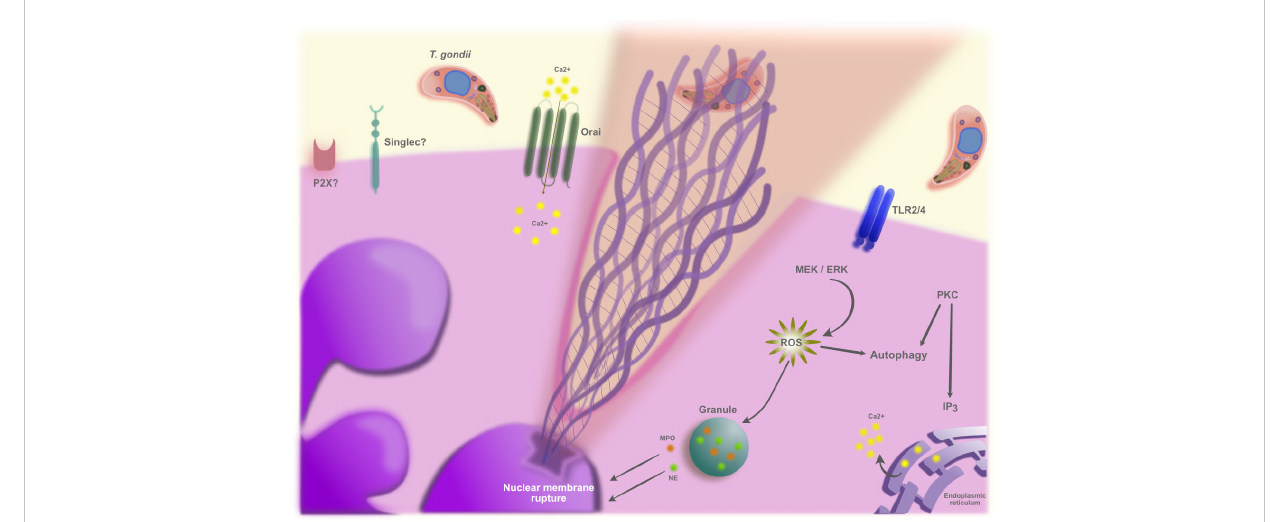
FIGURE 7 Schematic representation of the possible PMN signalling pathways involved in T. gondii -induced NET